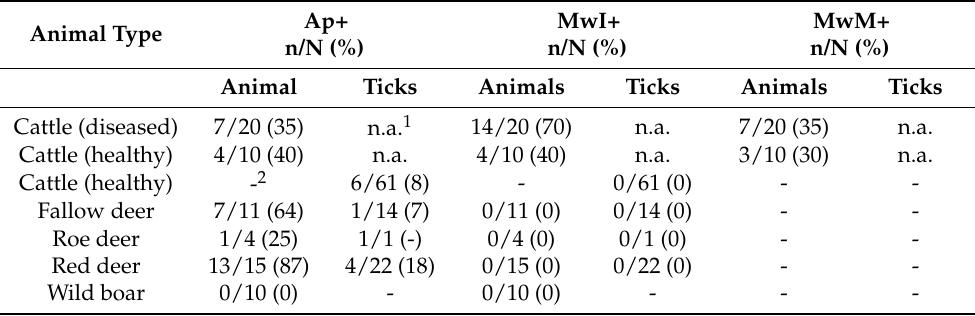
Table 2. Summary results of numbers (%) of animals where Anaplasma phagocytophilum (Ap+), Mycoplasma wenyonii strain INIFAP02-like (MwI+), or M. wenyonii strain Massachusetts-like (MwM+) were detected in blood (cattle) or spleen (deer and wild boar) samples and numbers of Ap+ or MwI+ ticks ( Ixodes ricinus , females) collected from cattle and